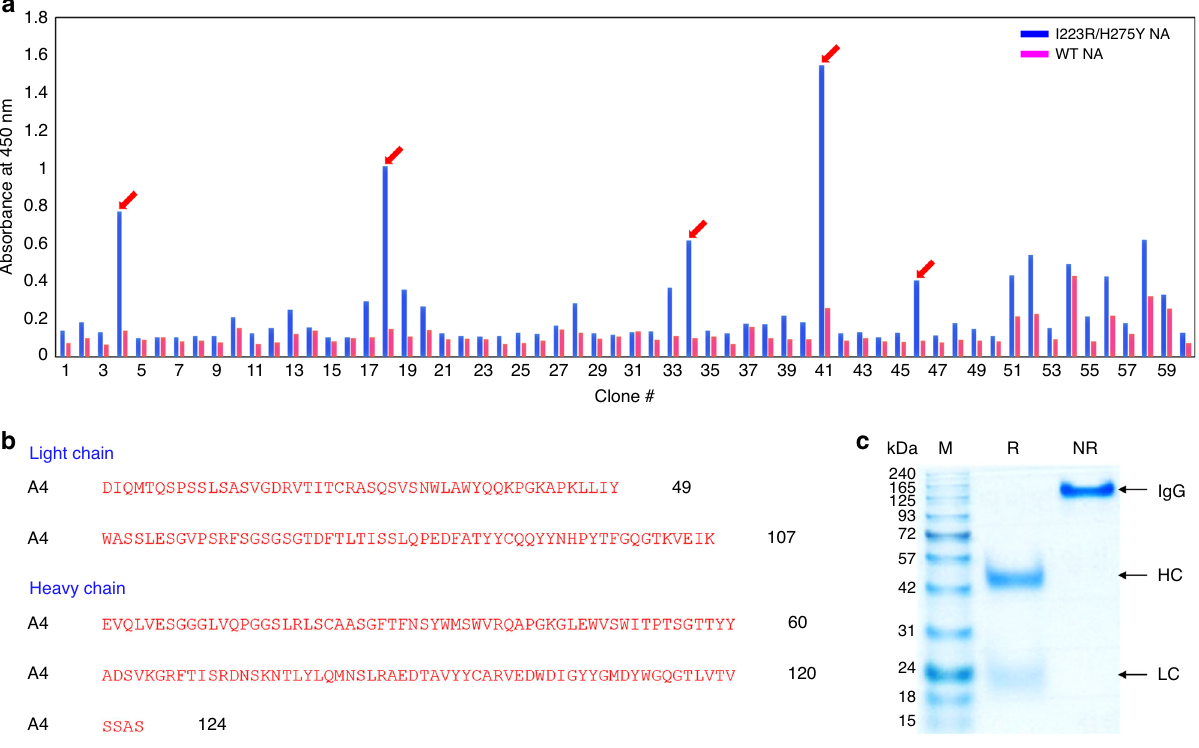
Fig. 1 Selection of I223R/H275Y NA-speci fi c monoclonal antibody. a Screening for the speci fi city of monoclonal phages from third round of panning by ELISA. Each experiment was repeated two times independently with similar results. b Amino acid sequence of A4. c SDS-PAGE of puri fi ed A4 under nonreducing (NR) and reducing (R) conditions. Each experiment was repeated three times independently with similar results. Lane M: protein marker; HC: heavy chain, LC: light